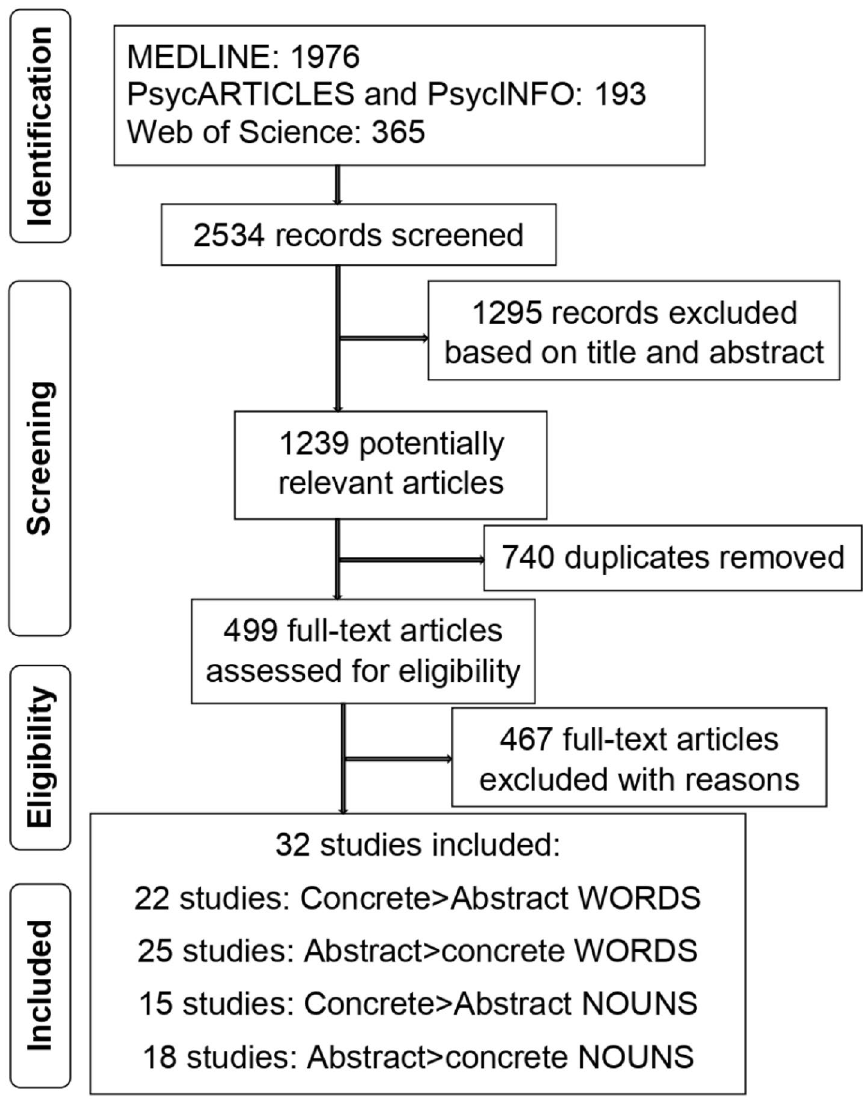
Figure 1. PRISMA flowchart of the selection process for included